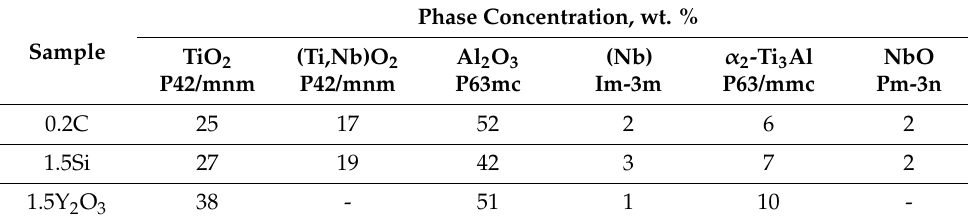
Figure 9. The XRD patterns of the oxidized layers of 0.2C, 1.5Si, and 1.5Y 2 O 3 alloys after annealing at 1100 °C. Table 5. The phase composition of the 0.2C, 1.5Si, and 1.5Y 2 O 3 alloys after oxidation annealing at 1100 °C.